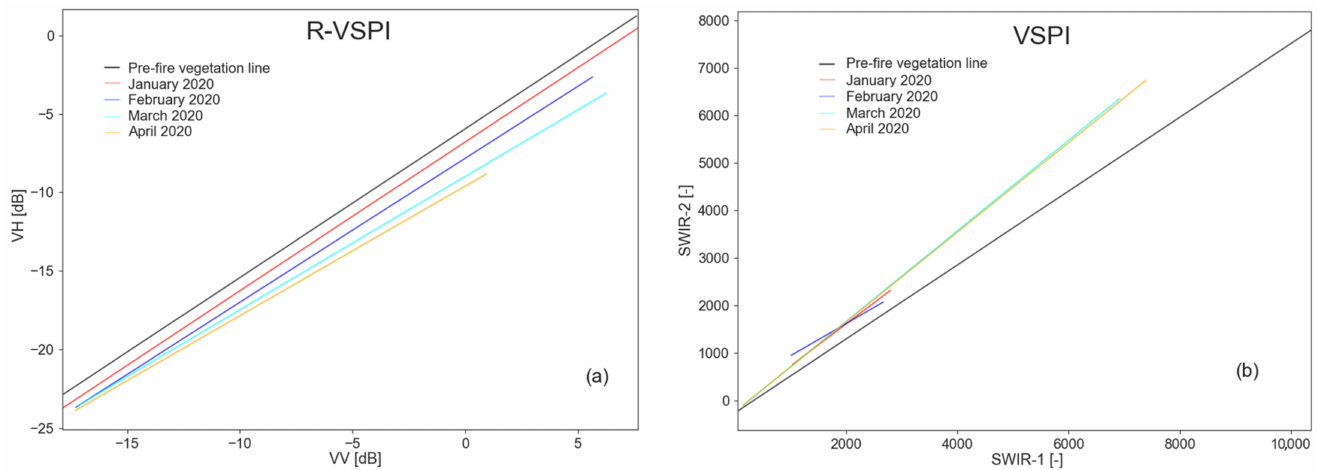
Figure 4. Illustration of vegetation and burnt area lines from ( a ) Sentinel-1 and ( b ) Sentinel-2 scaled surface reflectance data for the Orroral Valley wildfire. The solid line (black) represents the healthy vegetation, whereas the coloured solid isolines represents the displaced vegetation line during the post-fire months. The optical values of SWIR-1 and SWIR-2 bands are expressed in scaled surface reflectance values (unitless), whereas the backscatter values of VH and VV polarization channels are expressed in dB